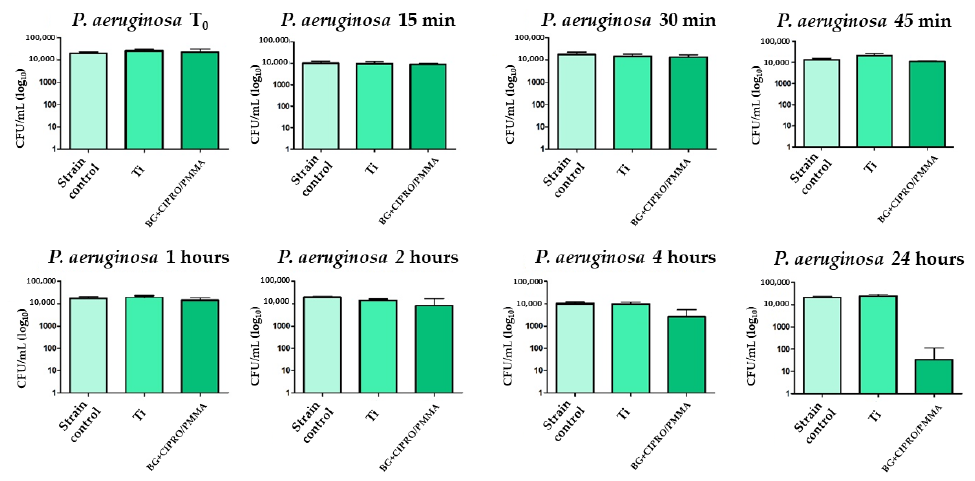
Figure 16. Evaluation of P. aeruginosa viability in the presence of bare Ti and BG+CIPRO/PMMA samples